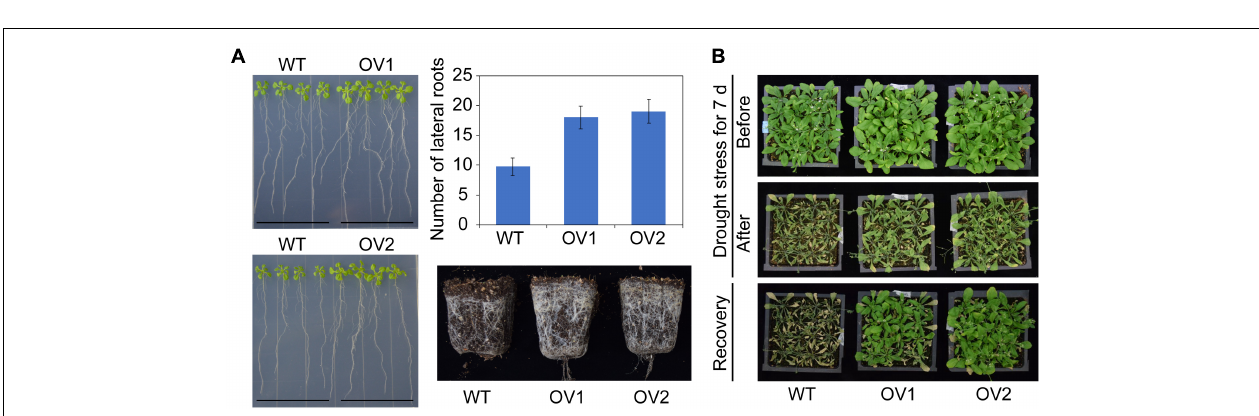
these results illustrate that overexpressed IbRAP2.4 promoted